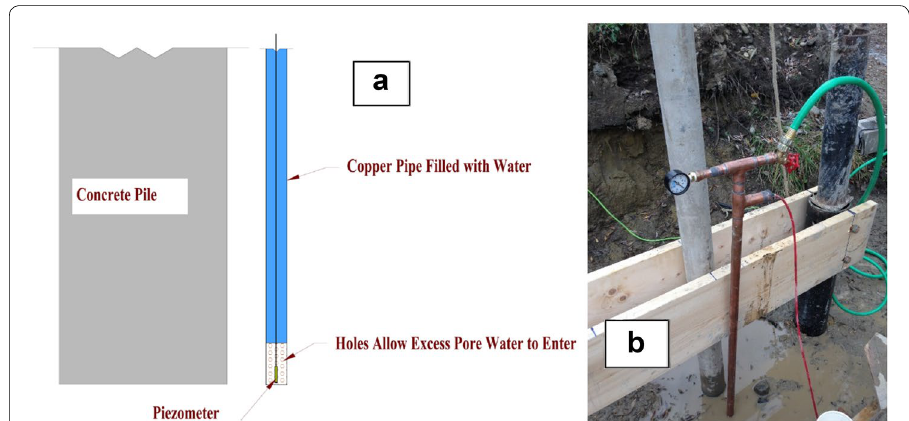
Fig. 4 a Schematic drawing of driven piezometer adjacent to the concrete pile b piezometer system adja- cent to the pile in test